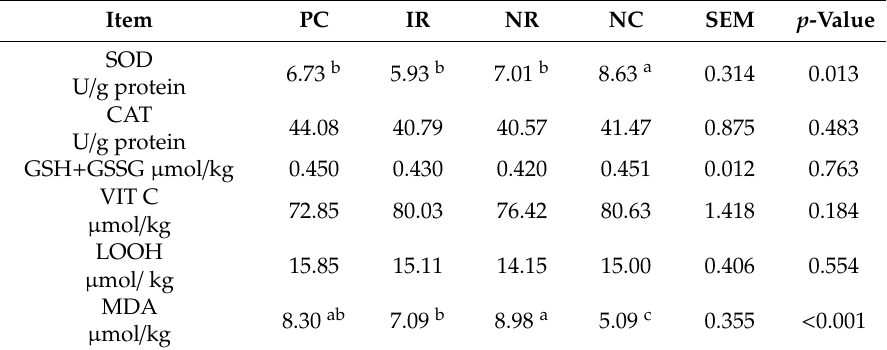
Table 7. Indicators of redox status in the small intestinal wall of